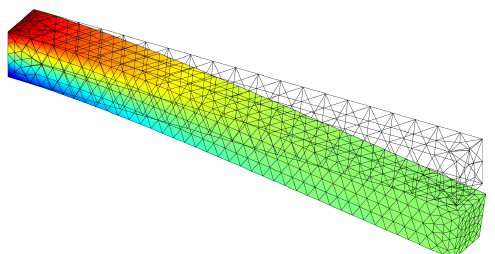
Figure 1. The finite element mesh discretizes the domain into a finite set of smaller subdomains, which are called elements. Over these elements, a set of basis functions are defined that approximately represent the PDEs that govern the system. As we refine the mesh by increasing the number of elements, the approximation will converge to the true